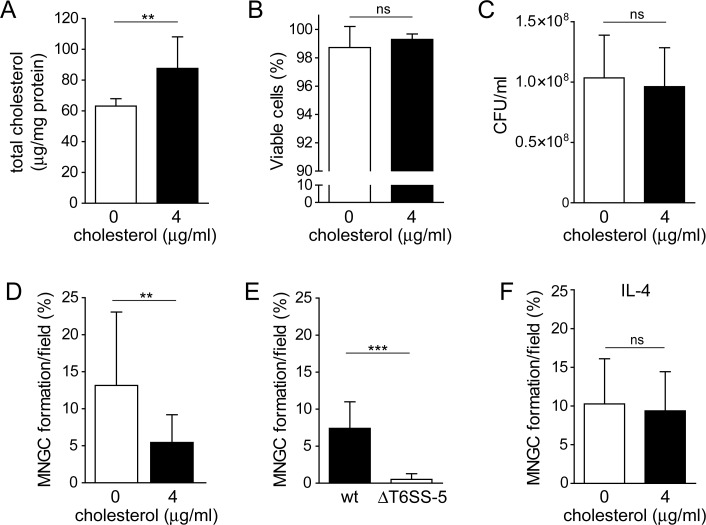
The exogenous addition of cholesterol to RAW264.7 macrophages at the time of infection with B. thailandensis reduces MNGC formation.A) Measurement of total cholesterol content of untreated (control) macrophages and cells treated with 4 μg/ml cholesterol for 10 h normalized to total cellular protein content. Shown are mean values + SD of two independent experiments performed in duplicate. **, P = 0.0087 (Welch’s t-test)/effect size: 5.100 (Glass’s Δ). B) Viability of macrophages after incubation with 4 μg/ml cholesterol for 10 h. Data represent mean + SD of two independent experiments performed in duplicate. ns, not significant; P value = 0.223 (Welch’s t-test)/effect size: 0.383 (Glass’s Δ). C) Number of B. thailandensis located inside macrophages infected at MOI 17 and simultaneously treated with cholesterol or left untreated at 10 h post-infection. Data are shown as mean values + SD of two independent experiments performed in duplicate. ns, not significant, P value = 0.67 (Welch’s t-test)/effect size: 2.429 (Glass’s Δ). D) MNGC formation of macrophages infected with B. thailandensis at an MOI of 17 and treated with 4 μg/ml cholesterol at the time of infection followed by a 10 h incubation period. Shown are mean values + SD of two independent experiments performed in duplicate. **, P = 0.0016 (Mann-Whitney test)/effect size: 0.478 (Mann-Whitney r). E) MNGC formation of macrophages infected with B. thailandensis wild type (wt) and ΔT6SS-5 mutant at MOI 17 and treated with cholesterol as described in D. Data represent mean values + SD of two independent experiments performed in duplicate. ***, P < 0.0001 (Mann-Whitney test)/effect size: 0.859 (Mann-Whitney r). F) MNGC formation of PMA differentiated THP-1 cells after treatment with 50 ng/ml IL-4 or 50 ng/ml IL-4 and 4 μg/ml cholesterol for three days. Data are shown as mean values + SD of two independent experiments performed in triplicate. ns, not significant, P value = 0.529 (t test)/effect size: 0.163 (Hedge’s g).